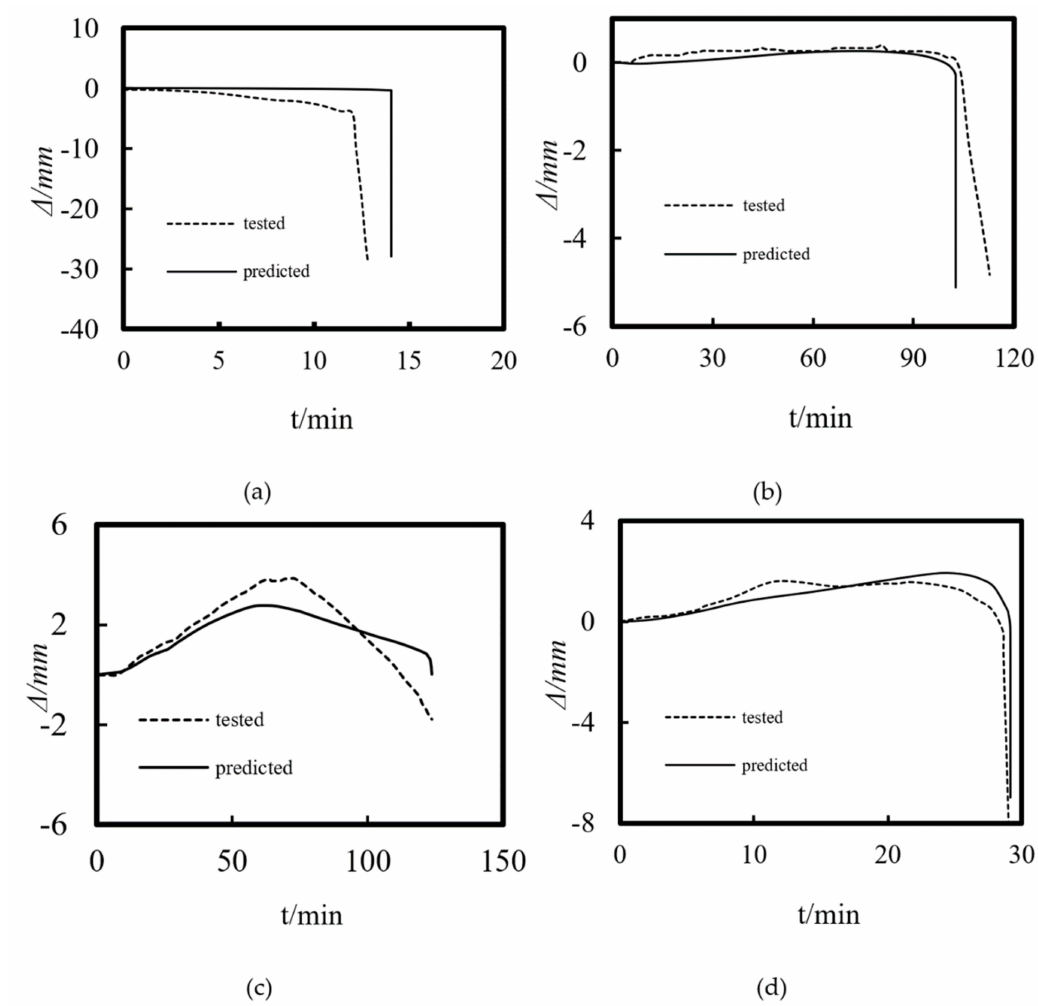
Figure 5. The comparison of the axial displacement versus time curves of the ST − RC columns ( a ) C4; ( b ) S4; ( c ) SZ1-1; ( d )